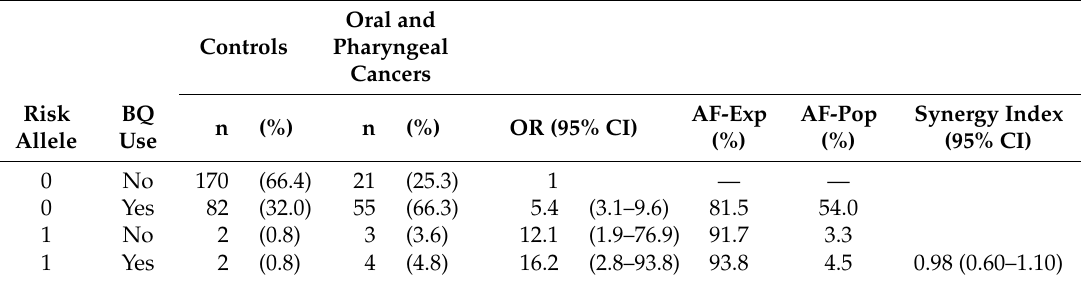
Table 3. Attribute risk for genetic Single Nucleotide Polymorphism (SNP) and betel quid use for oral and pharyngeal